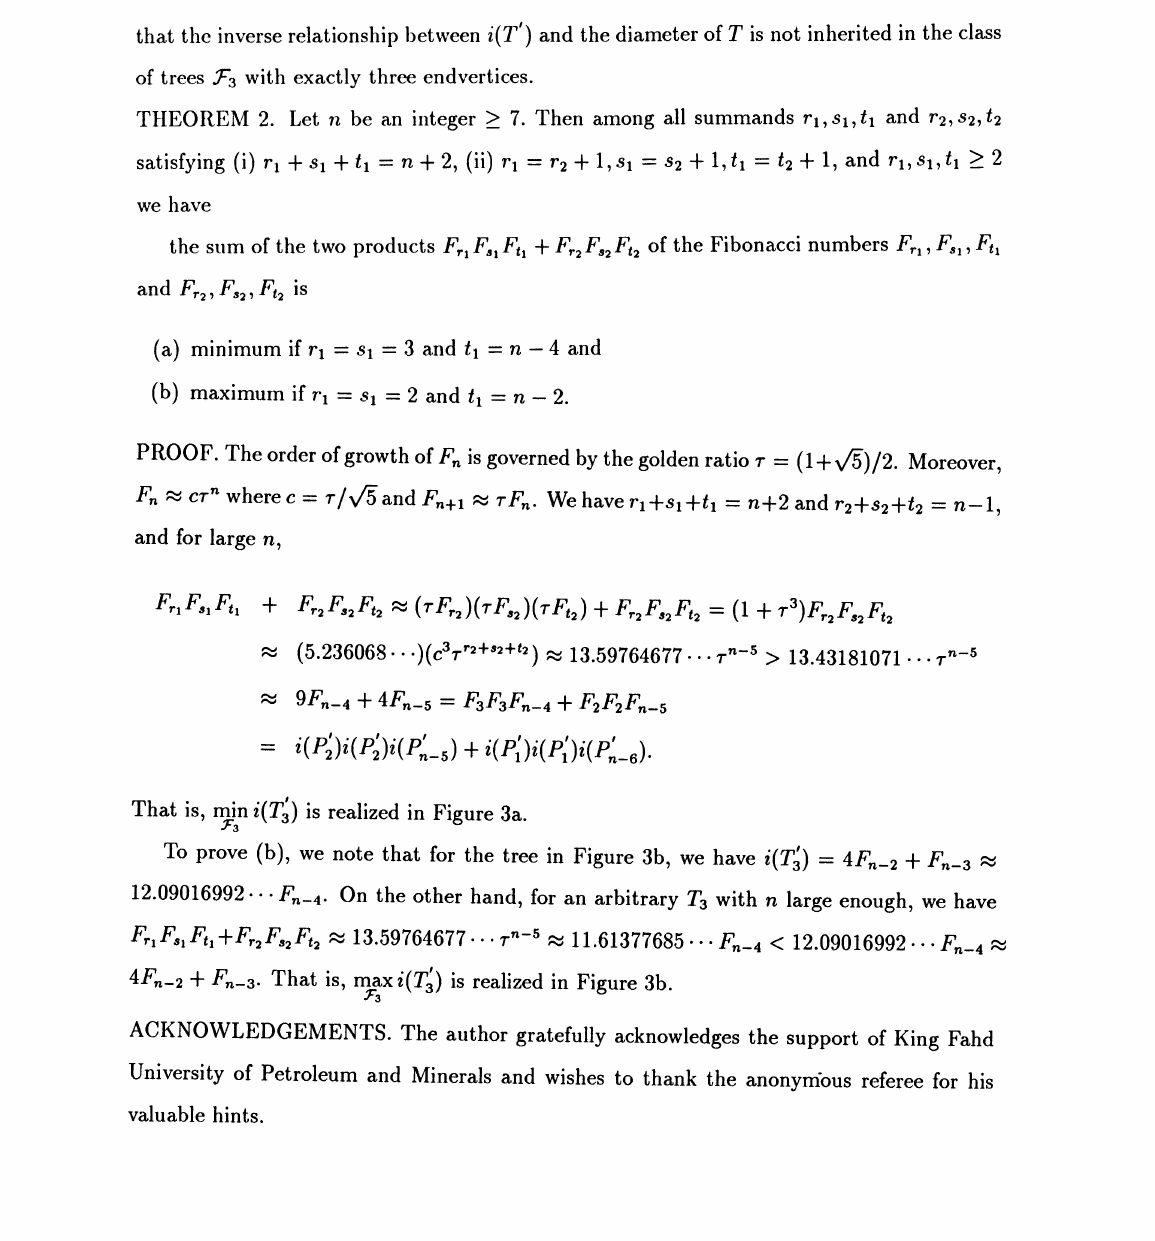
Figure 3. Extremal trees in